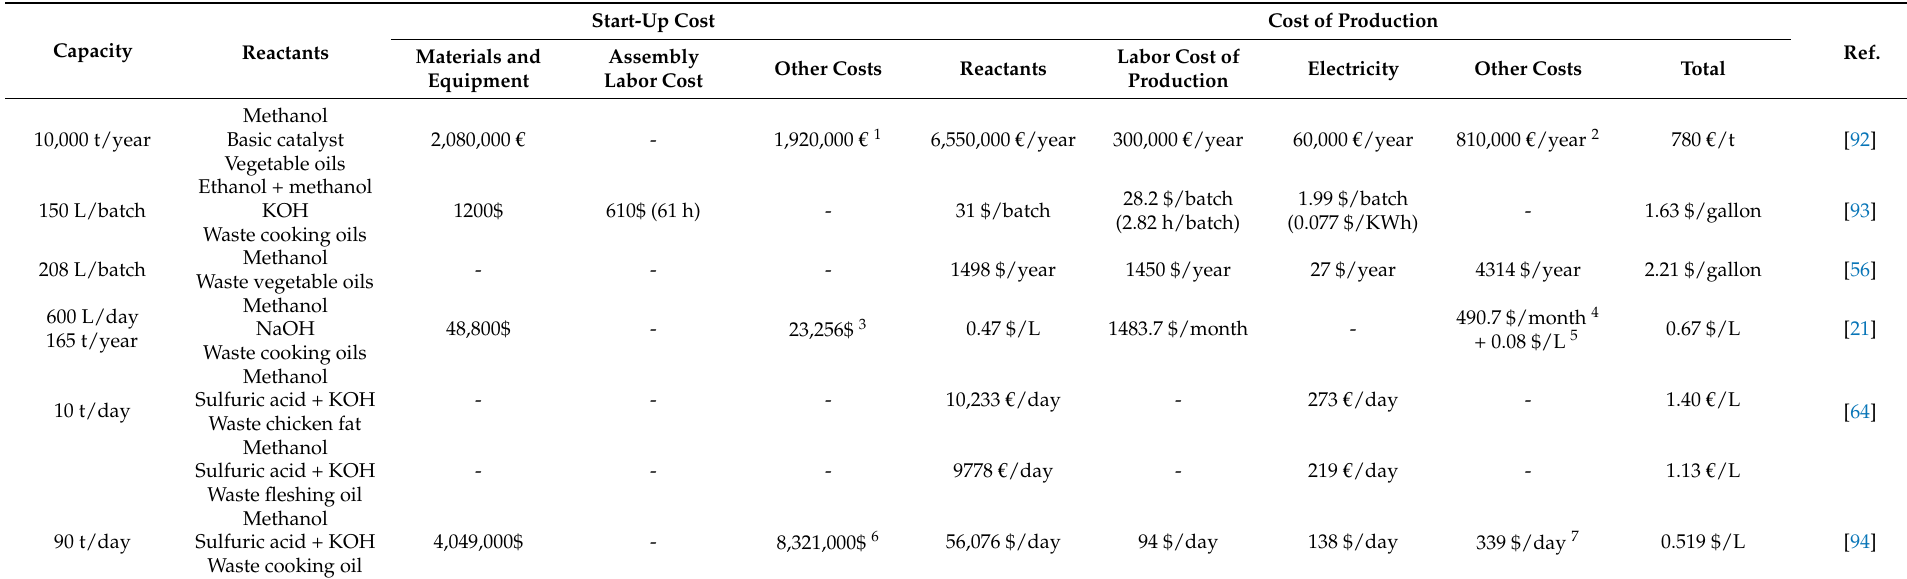
Table 5. Cost of production in small-scale plant producing biodiesel by basic transesterification from waste